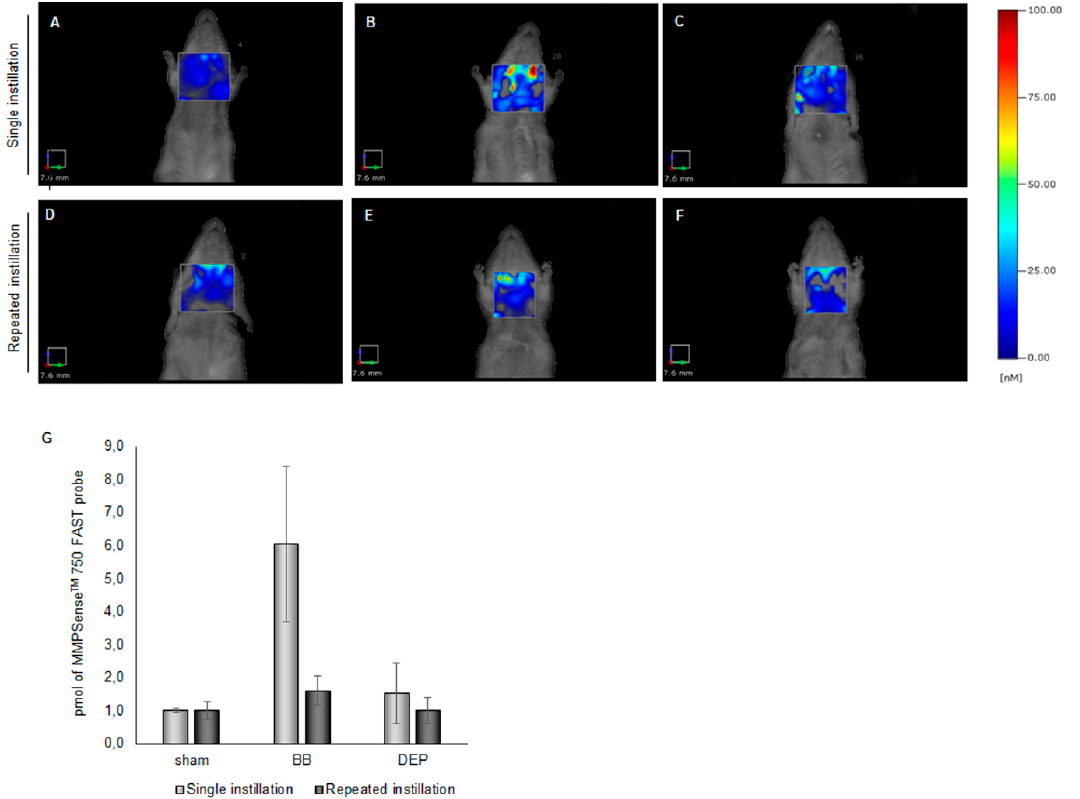
Figure 5. FMT of mouse thoracic region after the first ( A – C ) and the last ( D – F ) instillation of BB and DEP. Representative FMT images of sham ( A ), BB- ( B ) and DEP- ( C ) treated mice brain obtained 24 h after the first intratracheal instillation with 50 µ g of BB or DEP / 100 µ L 0.9% NaCl. Representative FMT images of sham ( D ), BB- ( E ) and DEP- ( F ) treated mice brain obtained 24 h after the last intratracheal instillation with 50 µ g of BB or DEP / 100 µ L 0.9% NaCl. Each figure represents the status evidenced examining two mice for every treatment, and histograms ( G ) are representative of pmol of MMPsense 750 FAST probe. Data are expressed as mean ± standard error.